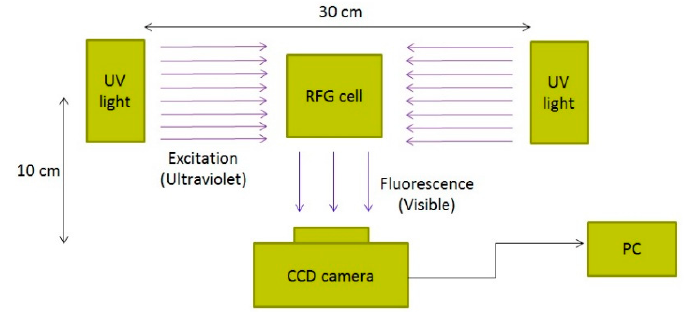
Figure 5. A schematic representation of the set-up used for fluorescence imaging of cells containing an irradiated RFG gel.